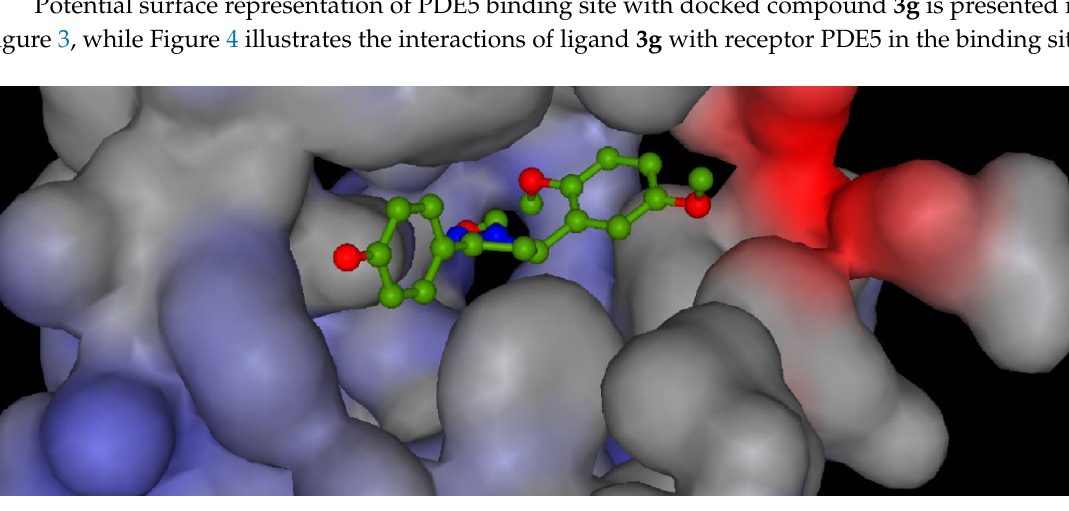
Figure 3. Potential surface representation catalytic domain of PDE5 with docked compound 3g . (Range of potential: from min. 1.77 mV (blue) to max. 0.541 mV (red)).